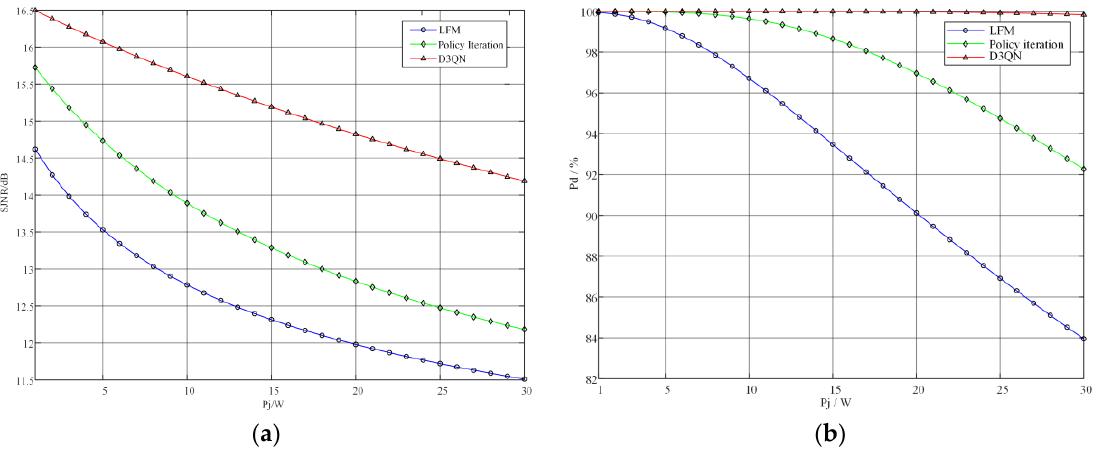
Figure 12. The performance of different signals when the jamming power changes. ( a ) SJNR of different transmitted signals; ( b ) detection probability of different transmitted signals.